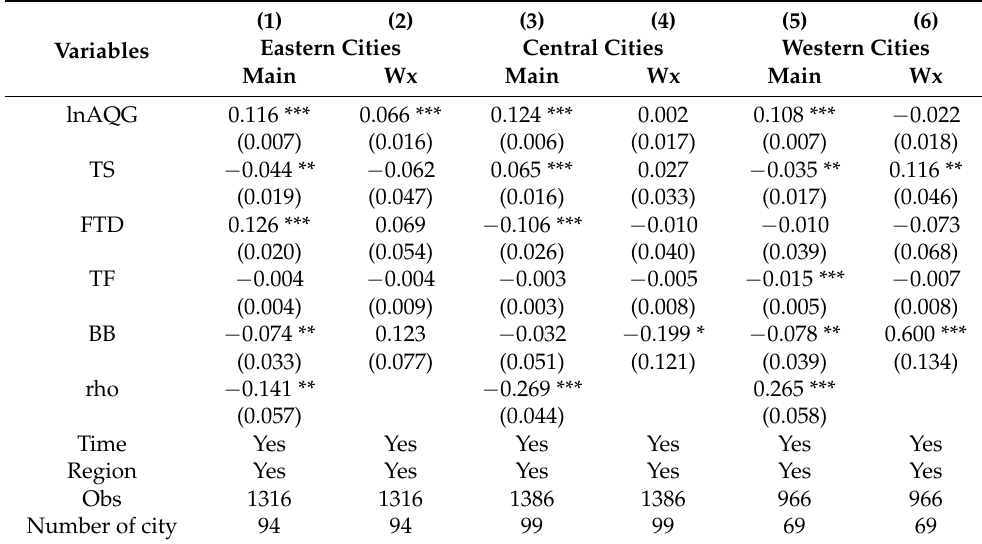
Table 5. Impact of air quality improvement on enterprise productivity in eastern, central, and western China.